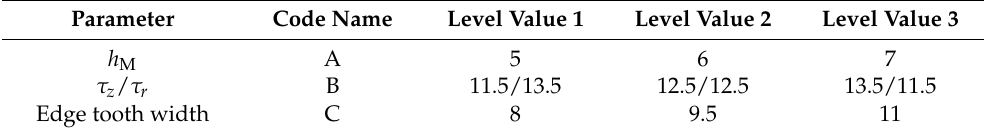
Table 2. Values of structural parameters.